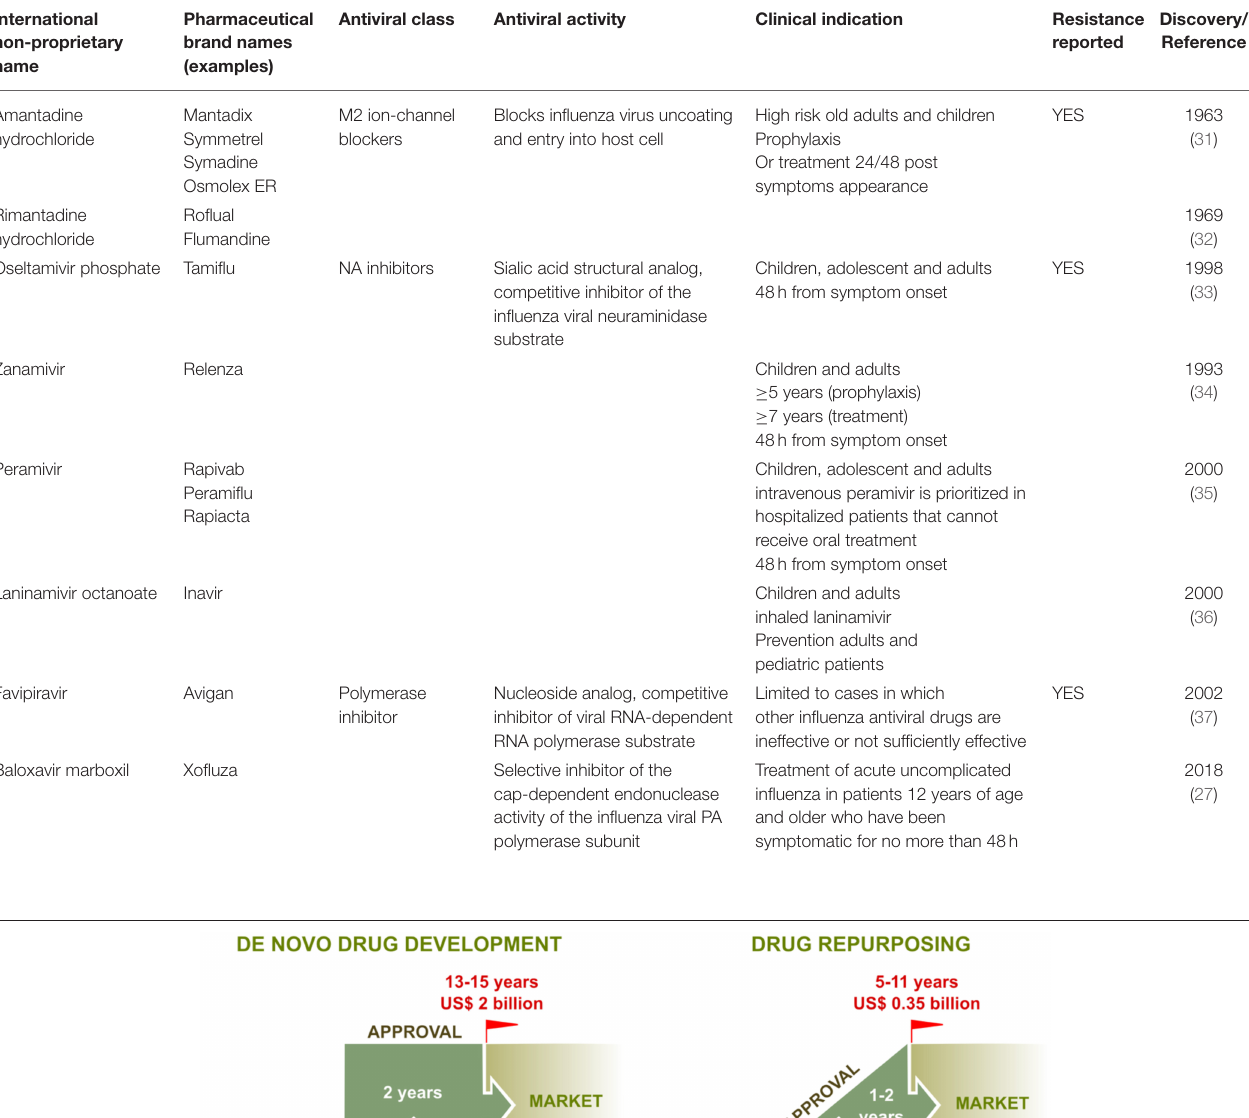
TABLE 1 | Currently approved drugs for the treatment of influenza viral infections.